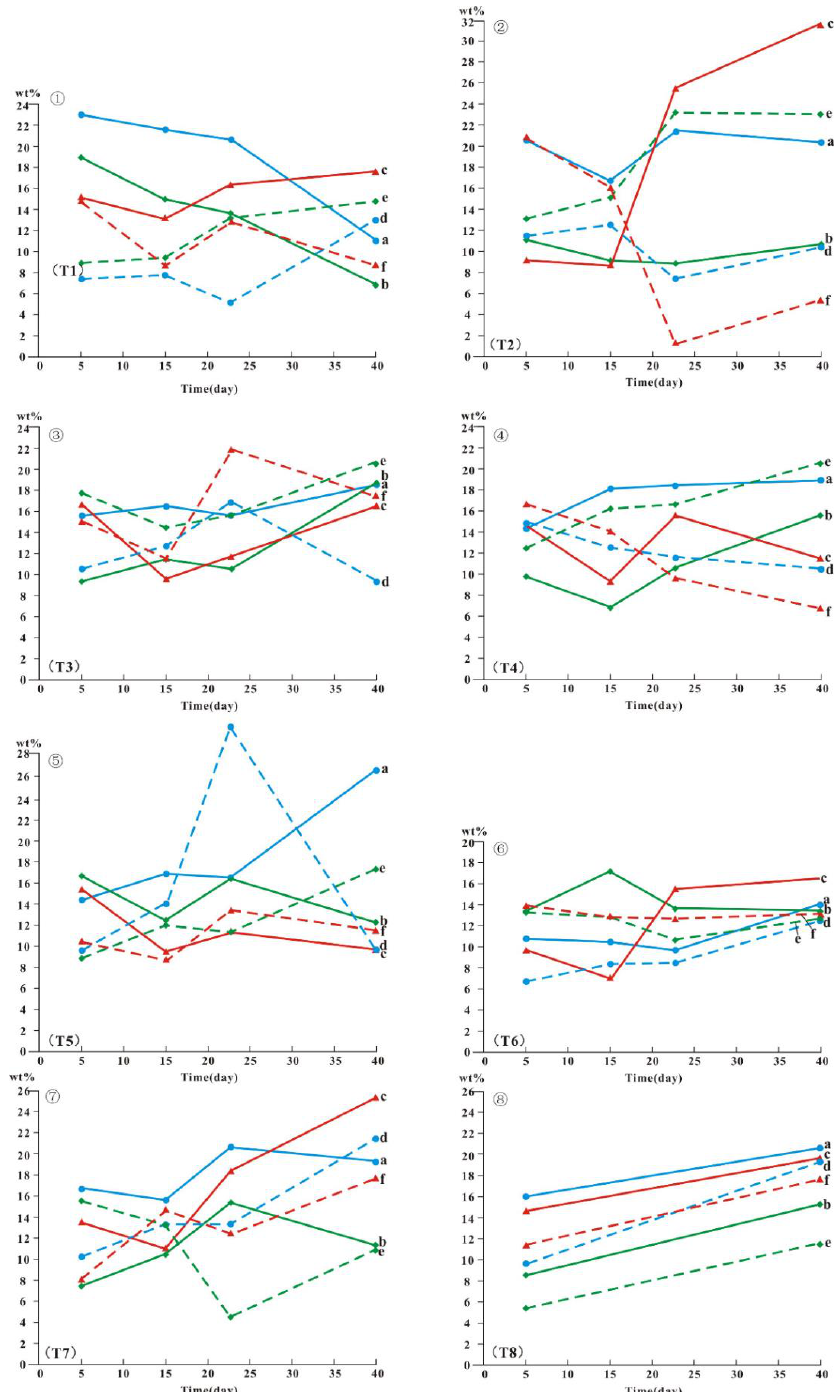
Figure 12. Changing clay mineral content in different conditions of simulated leaching. ( a – c ) kaolinite content sample at sample locations of 30, 70, and 110 cm, respectively; ( d – f ) illite-mica content at sample locations of 30, 70, and 110 cm, respectively.